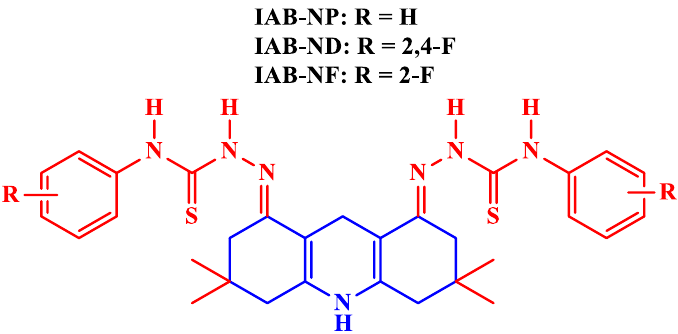
Figure 4. Acridine-based thiosemicarbazones as corrosion inhibitors.